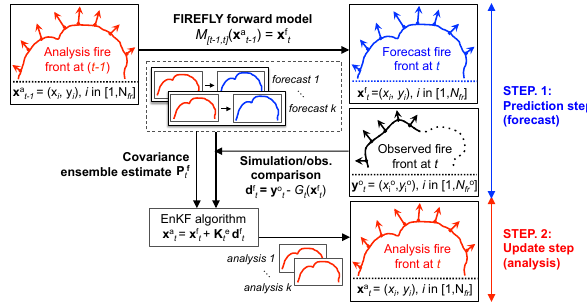
Figure 2. Flowchart of the EnKF algorithm during the [ t − 1, t ] assimilation cycle for a SE